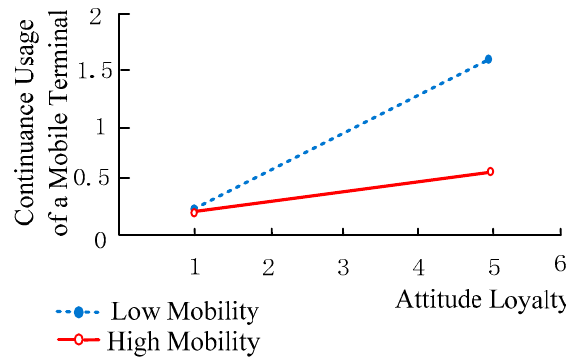
Figure 4. Moderating effect.